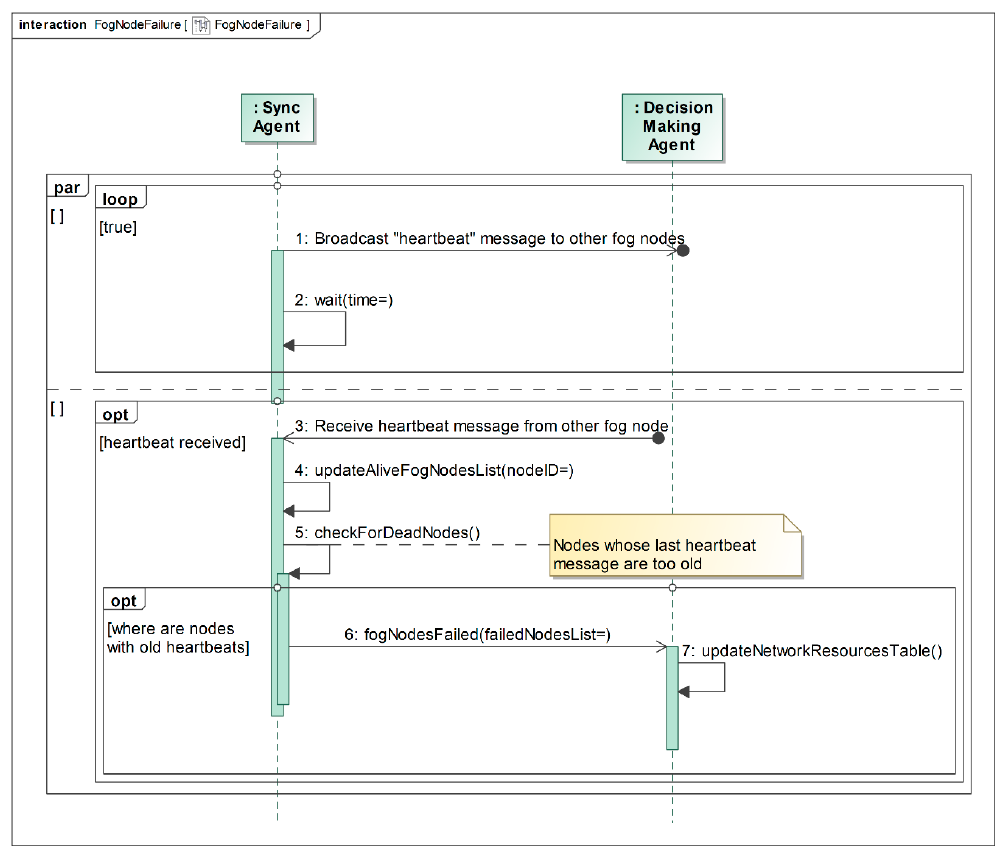
Figure 7. Fog node failure detection using heartbeat messages.